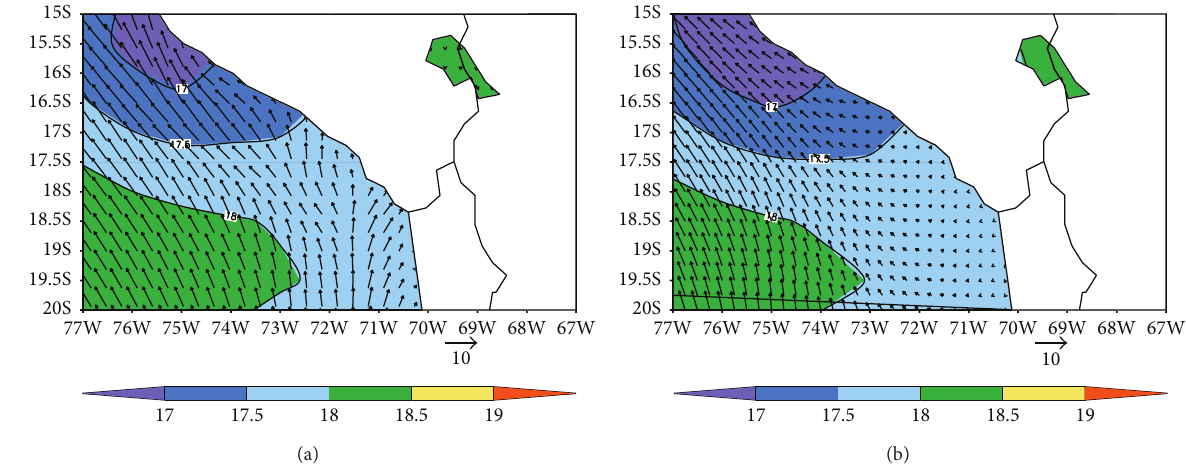
Figure 1: JJA climatology SST shaded (units: degrees C) surface wind vector (units: m/s) for (a) NOAA OI SST and CFS reanalysis surface wind (b) like (a), except using NOAA’s blended sea-wind dataset.